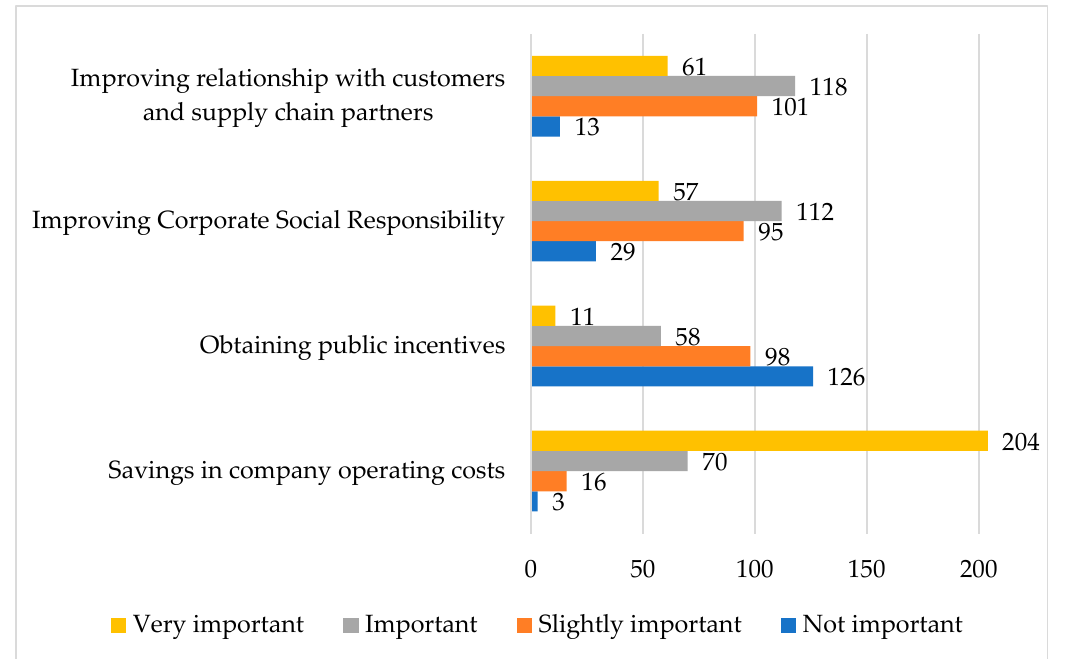
Figure 2. Companies’ evaluation of the drivers for implementing energy efficiency measures.